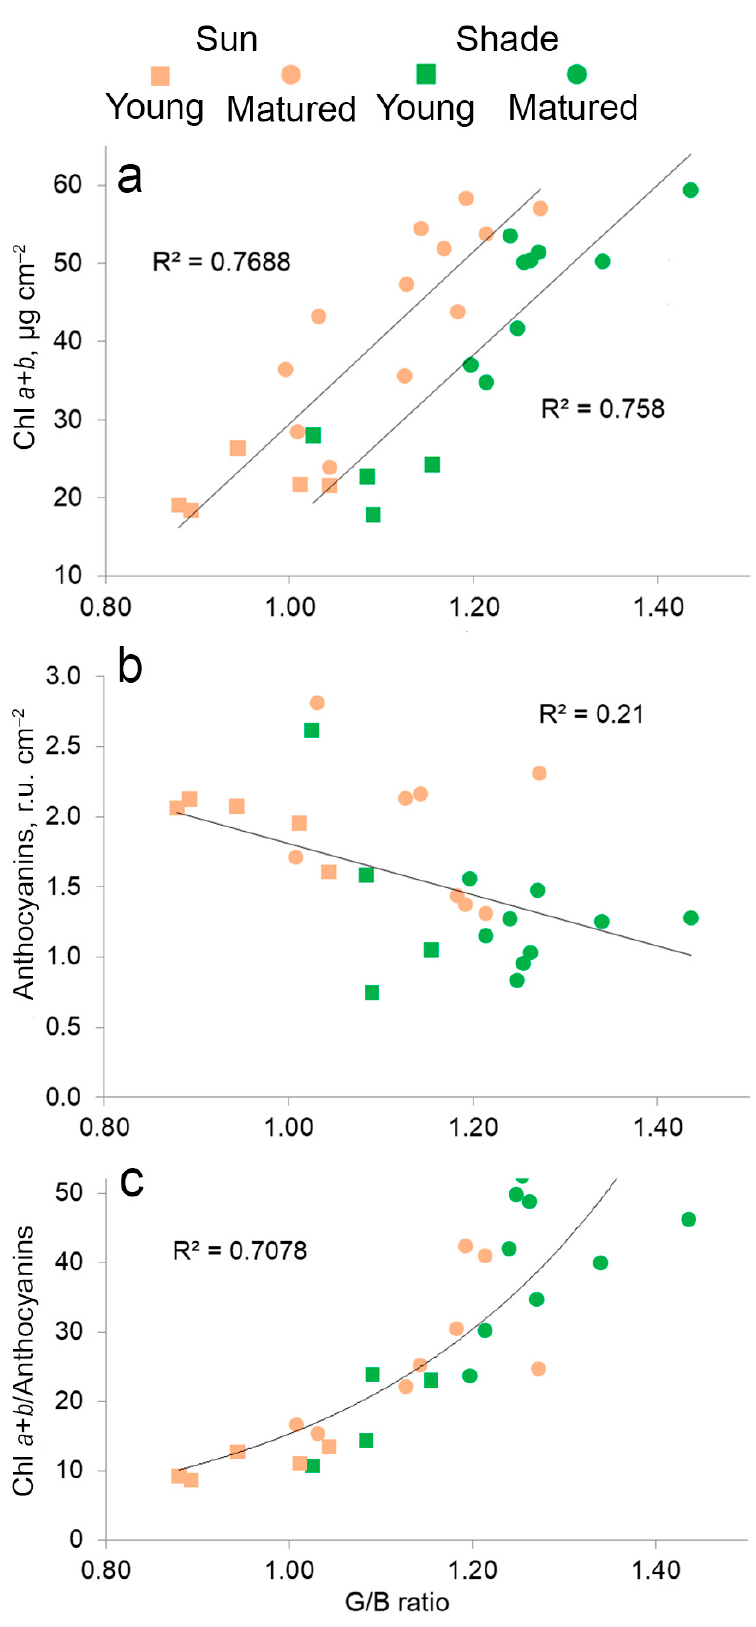
Figure 8. Relationship between digital values of leaf color G/B (a ratio of mean values of green to blue) and chlorophylls ( a ), anthocyanins ( b ) and ratio of chlorophylls to anthocyanins ( c ) in young and mature leaves of Hydrocharis morsus-ranae grown in the shade and